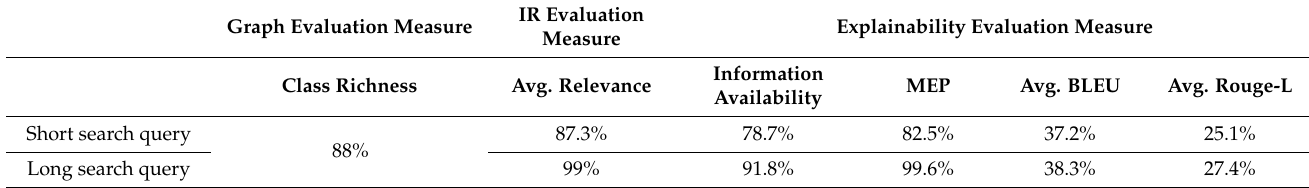
Table 2. Evaluation results of the proposed framework on Use Case